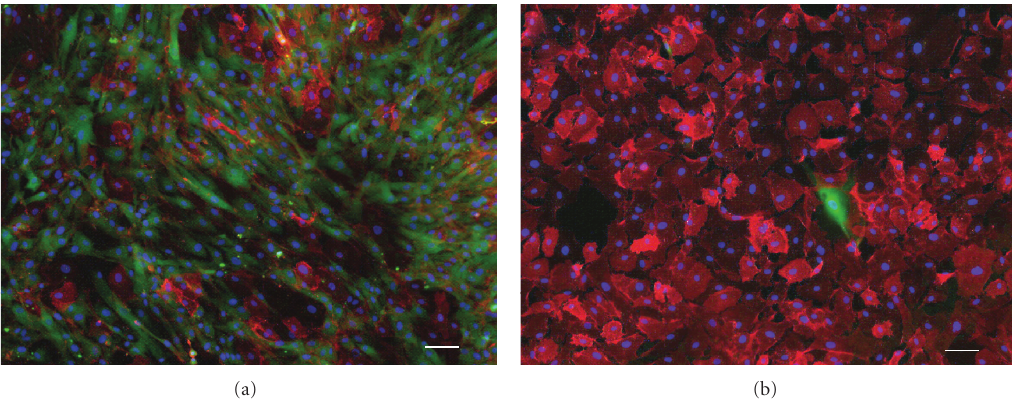
Figure 4: Composite fluorescent micrograph images of CMFDA (green) and Na + /K + ATPase pumps (red) of cultured cells established from (a) the “labeled” fraction and (b) the “flow-through” fraction. Cell nuclei were counterstained with DAPI in blue. (Scale bar = 100 μ